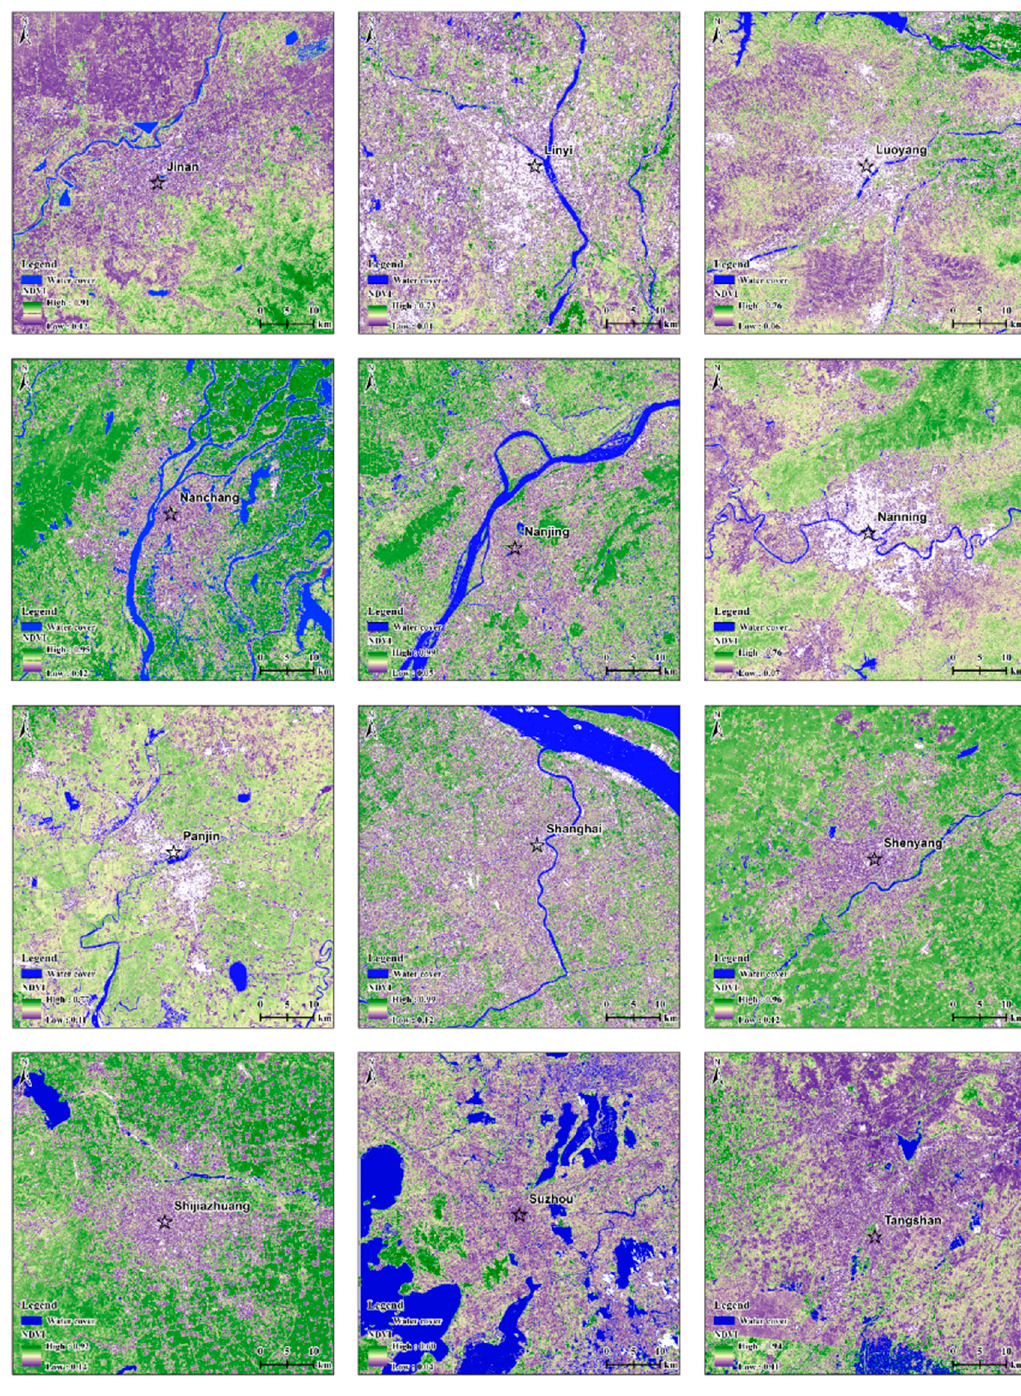
Figure A3. Figure A3. Map of the normalized difference vegetation index (NDVI) data and water cover (WC) data for the 32 Chinese cities